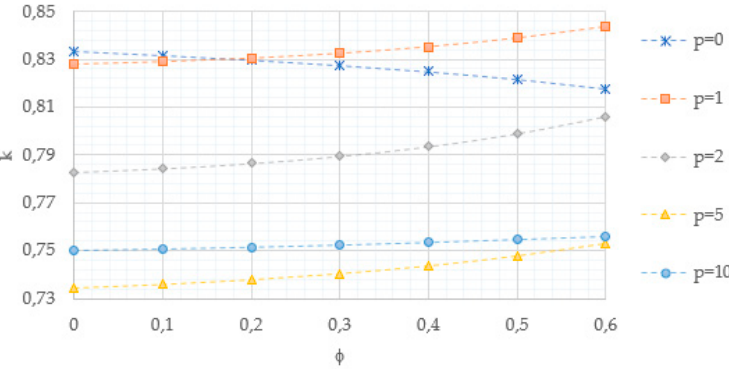
Figure 10. Porosity distribution model M1: evolution of shear correction factor.